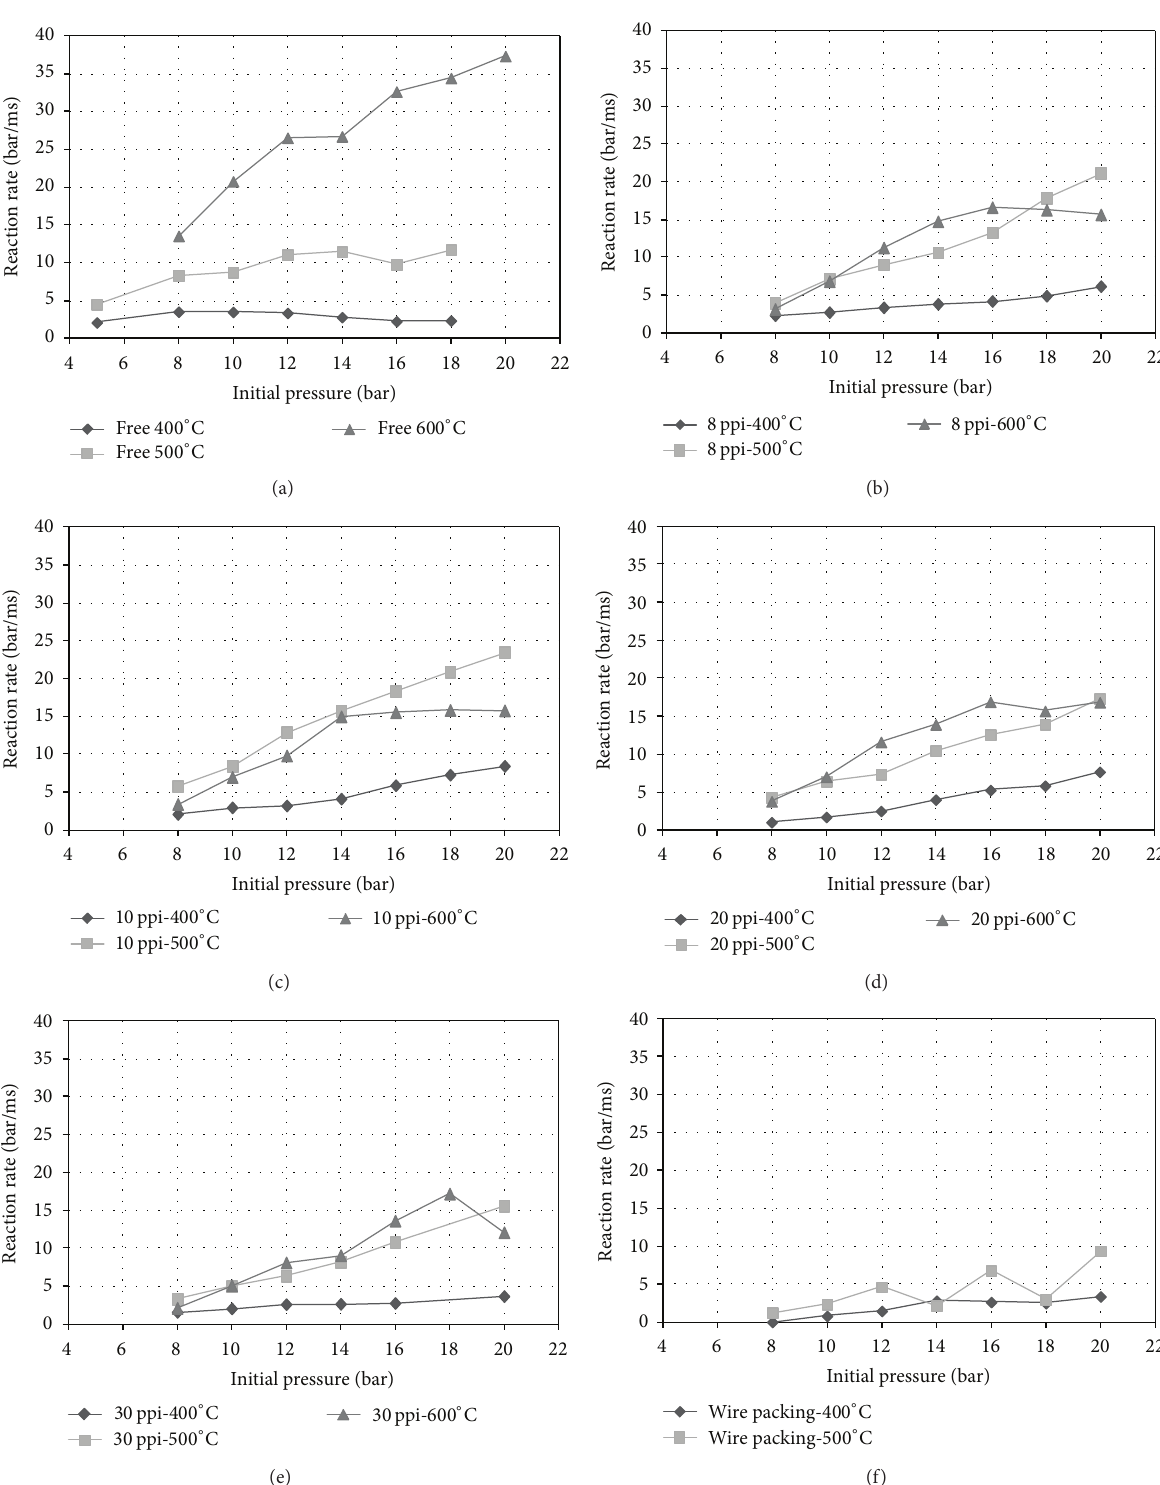
for three initial temperatures 400 ∘ C, 500 ∘ C, and 600 ∘ C (mass of injected IB